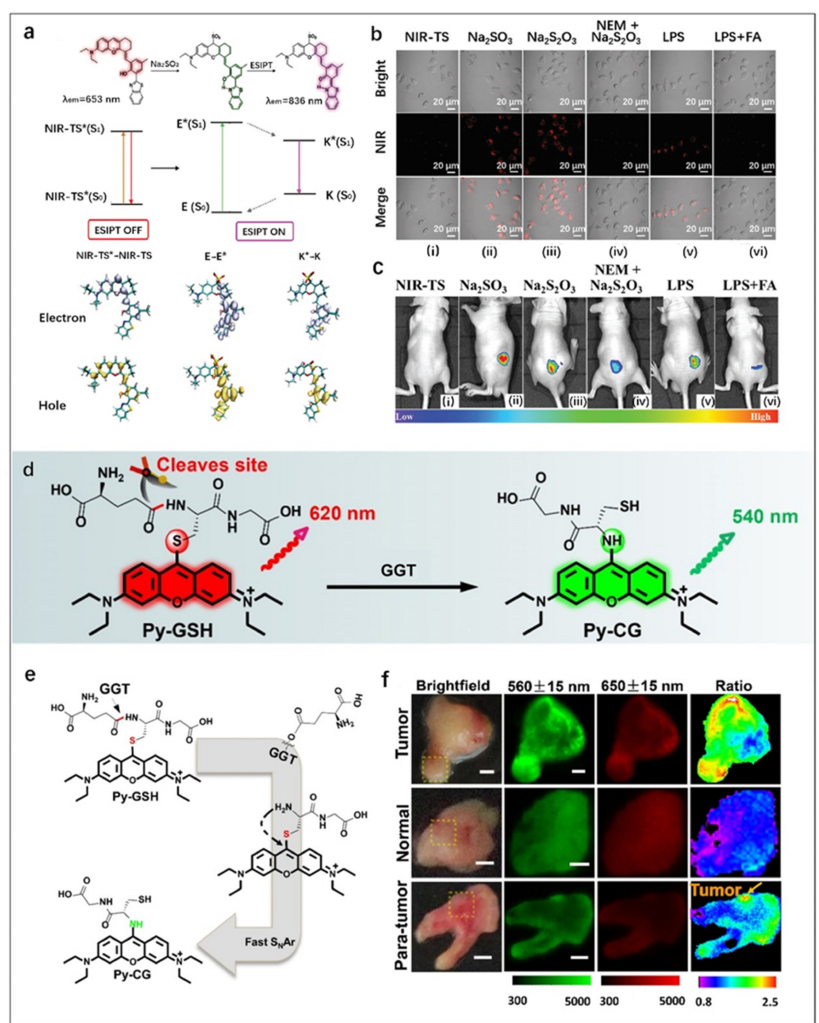
Figure 6. ( a ) Design of NIR-TS probe for SO 2 detection. ( b ) NIR fluorescence imaging of SO 2 (Na 2 SO 3 ) in HeLa cells. ( i ) HeLa cells were incubated with the NIR-TS probe (10 µ M) for 15